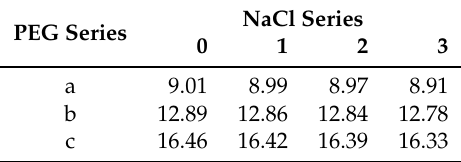
Table 8. Weight fractions (%) of PEG in the solutions used in experiments.